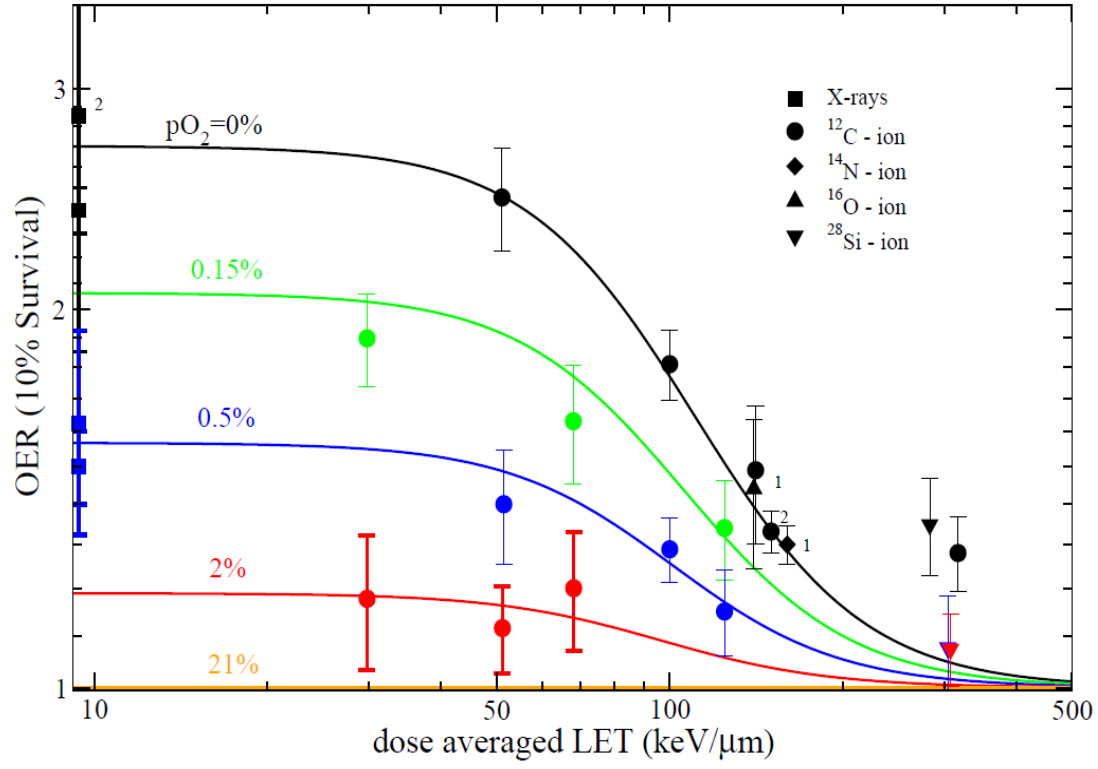
Figure 10. OER vs. LET of CHO cells at different oxygen concentration levels. Figure from reference [158], distributed under Creative Commons CC-BY.